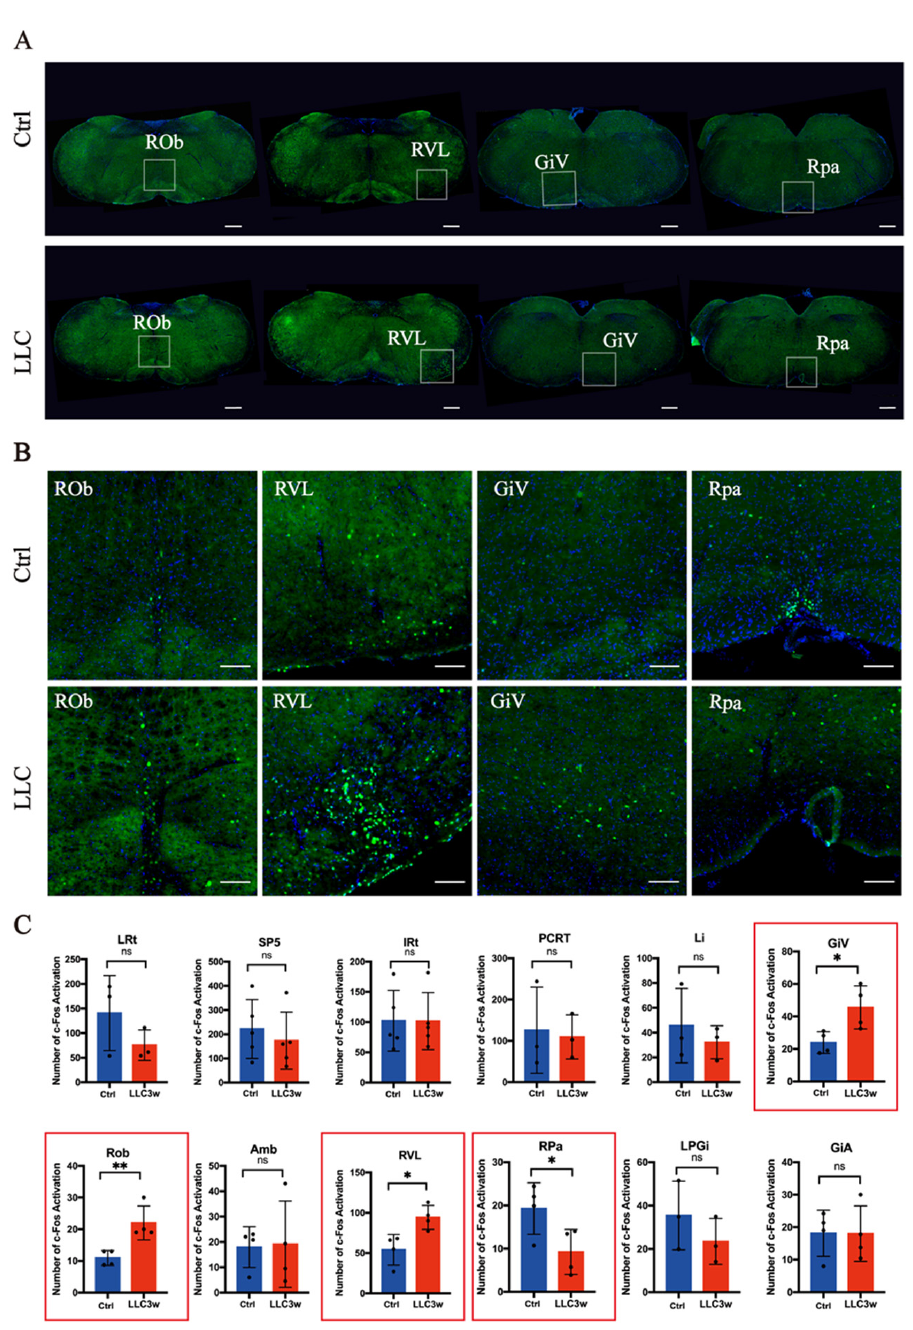
Figure 2. Overall c-Fos activation patterns in the medulla oblongata. ( A ) Overview of coronal Figure 2. Overall c ‐ Fos activation patterns in the medulla oblongata. ( A ) Overview of coronal sec ‐ sections in the medulla oblongata of LLC and control mice (scale bar = 400 µ m). ( B ) Enlarged tions in the medulla oblongata of LLC and control mice (scale bar = 400 μ m). ( B ) Enlarged photomicrographs of the medulla oblongata regions illustrate c-Fos activation in various brain structures of LLC and control mice (scale bar = 100 µ m). ( C ) Levels of c-Fos-activated neurons in LLC and control groups. There are significant differences in GiV ( p < 0.05), ROb ( p < 0.01), RVL ( p < 0.05), and RPa ( p < 0.05) between the LLC group and the control group ( p < 0.05). PCRt= parvicellular reticular nucleus, Li = linear nucleus of the medulla, Amb = ambiguus nucleus, and LPGi = lateral paragigantocellular nucleus. “*” represents p < 0.05, “**” represents p < 0.01, “ns” represents no significant differences, red bars represent the experimental group (LLC3w) and blue bars represent the control group (Ctrl). Statistically different nuclei are represented in the red